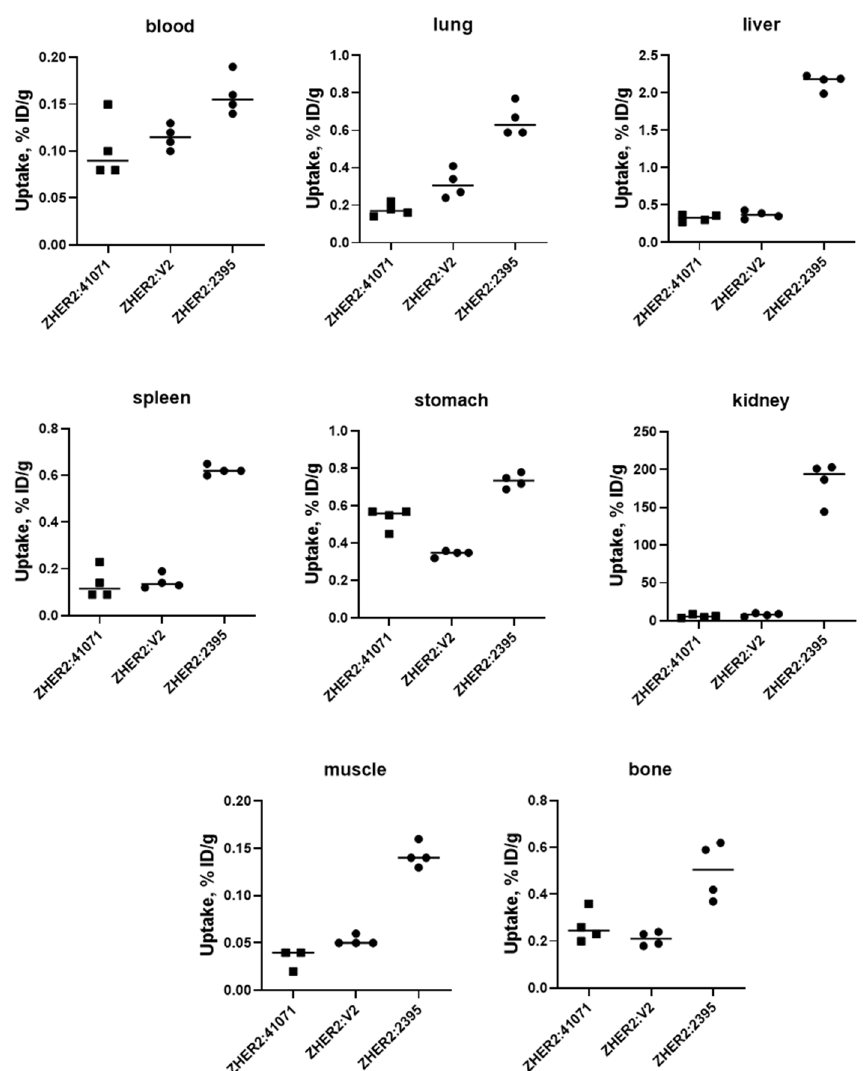
Figure 7. Uptake of 99m Tc-labelled affibody molecules in different organs of female NMRI mice at 4 h after injection. Then, 1 µ g of labelled affibody molecules (60 kBq, 100 µ L in PBS) was injected into the tail vein.